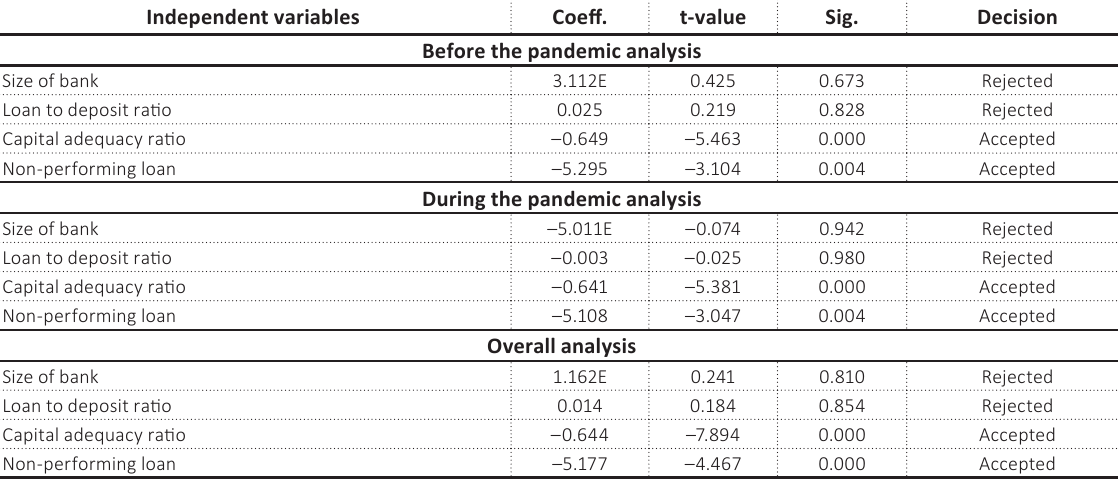
Table 3. Determinants of ROE before and during the pandemic